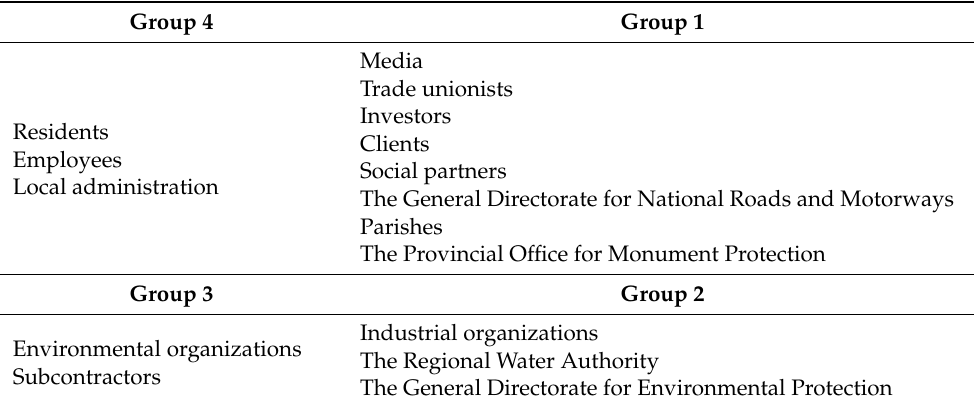
Figure 6. The G. Johnson and K. Scholes matrix for the Cyców LW Bogdanka mining area. Source: the authors’ own study. Table 7. The assignment of the stakeholder groups to the groups identified in the G. Johnson and K. Scholes